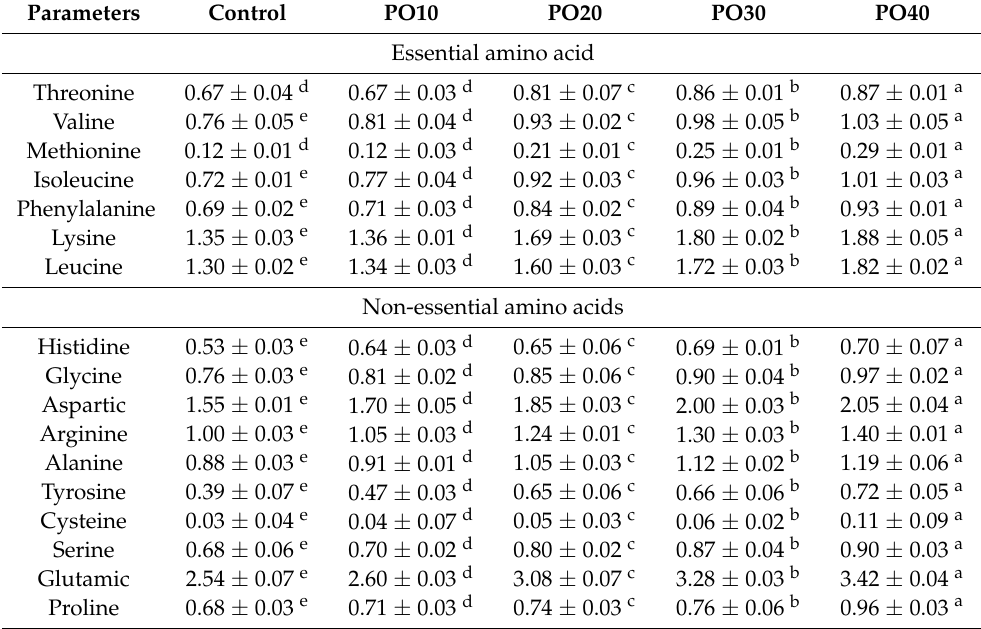
Table 5. Amino acid profile (%) of Pleurotus ostreatus (PO) sausages during storage.